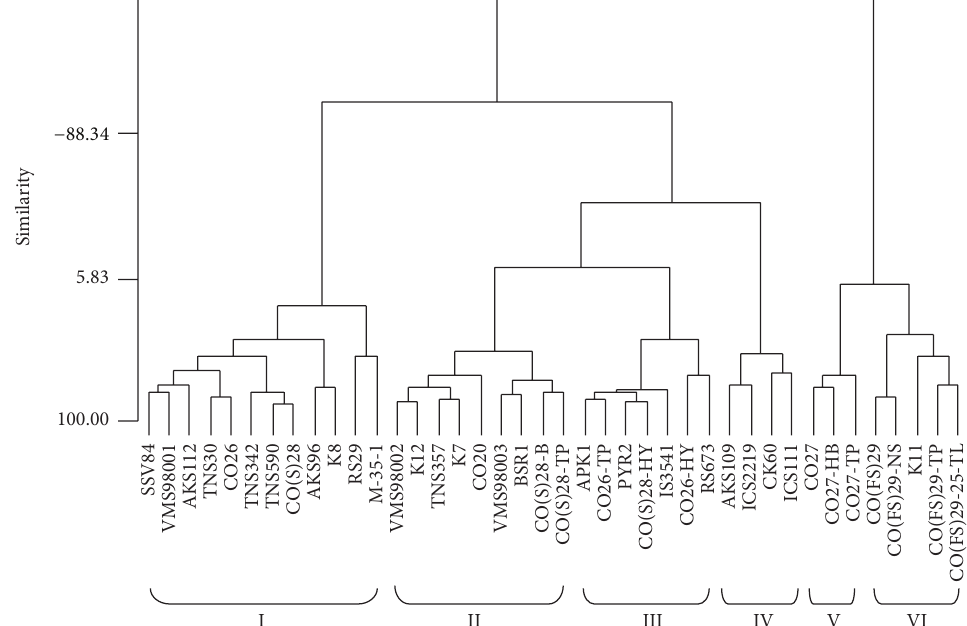
Figure 3: Dendrogram of sorghum accessions based on nine quantitative